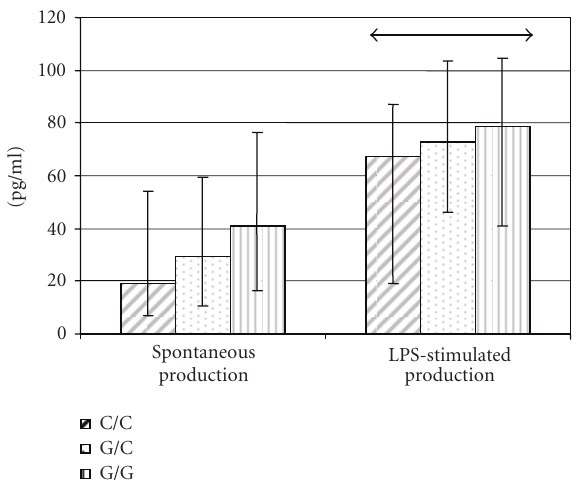
Figure 1: E ff ect of polymorphic variants in the IL-18 gene promoter region at − 137 G → C on IL-18 protein production by PBMC (data are represented as median and 25 and 75 percentiles) = 0 . 0494). ( ↔ p Mann-Uitni